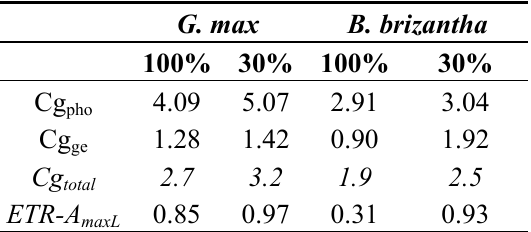
Table 8. Global connectance values of all physiological network ( Cg network ( Cg ) and of the gas exchange network ( Cg pho photochemical module and the gas exchange module of the network, represented by the ETR- A ratio observed in G. max and in B. brizantha under different water regimes (100% maxL or